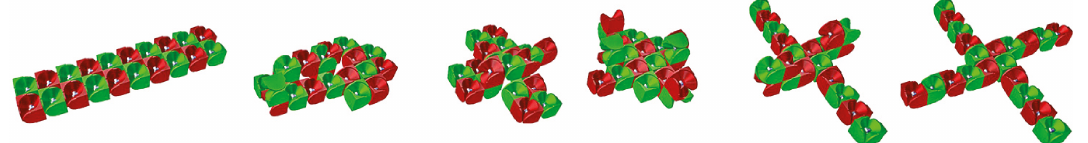
Figure 11: Self-recon fi guration process to a cross shape con fi guration.